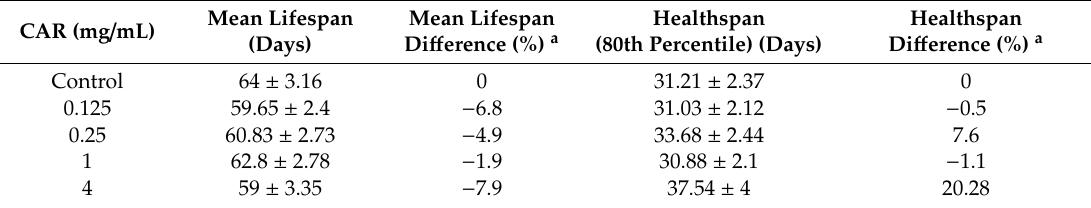
Table 4. E ff ects of CAR treatments on the Drosophila melanogaster mean lifespan and healthspan. CAR (mg /